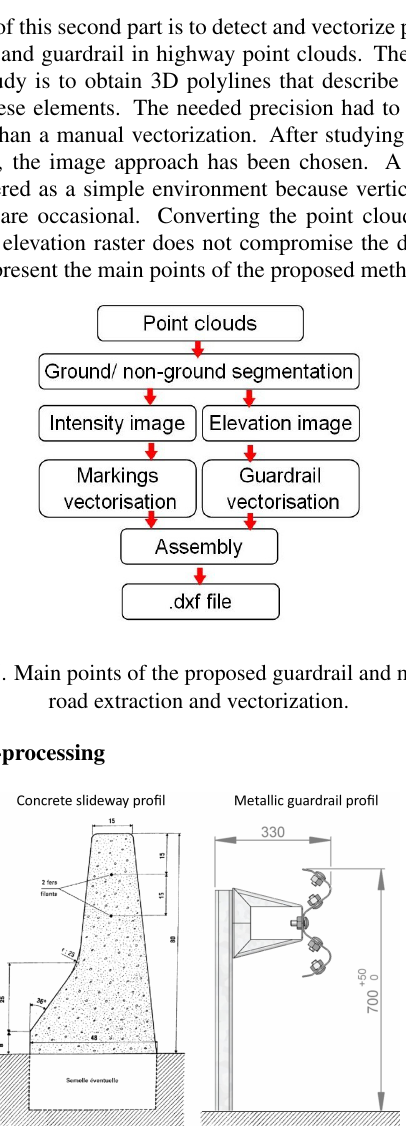
Figure 6. Profiles of the most encountered guardrail in